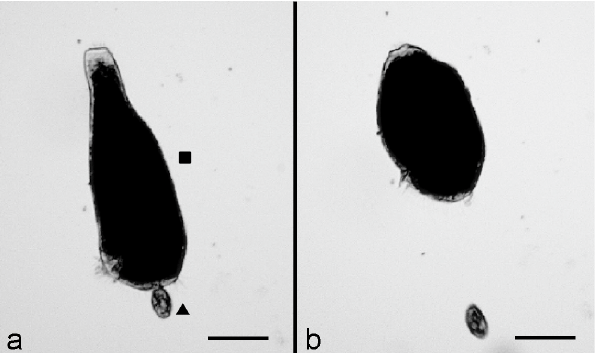
Figure 1. Predator-prey interaction between C. hirtus ( (cid:78) ) and S. polymorphus ( (cid:4) ). ( a ) A cell of C. hirtus has an effective contact with a cell of S. polymorphus with its anterior portion. ( b ) The prey shows a contraction and becomes ovoid while the predator swims backwards. Photomicrographs obtained from a film clip. Scale bar = 100 µ m.